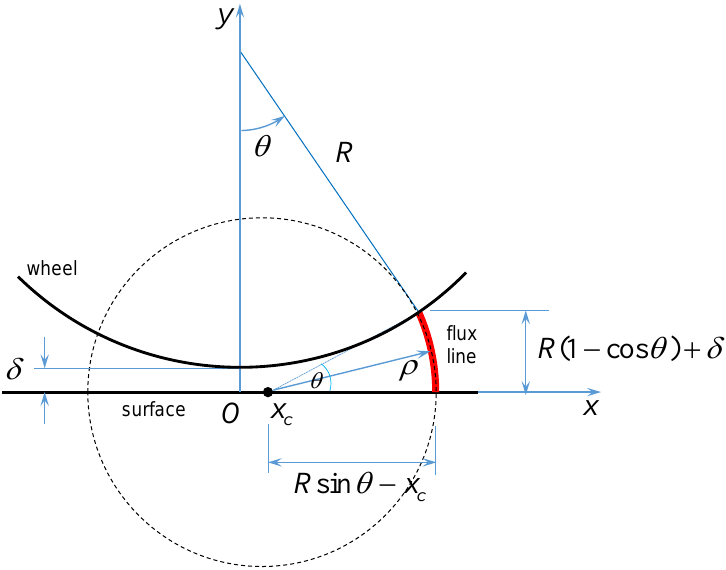
Figure 2. Coordinates and the definitions of